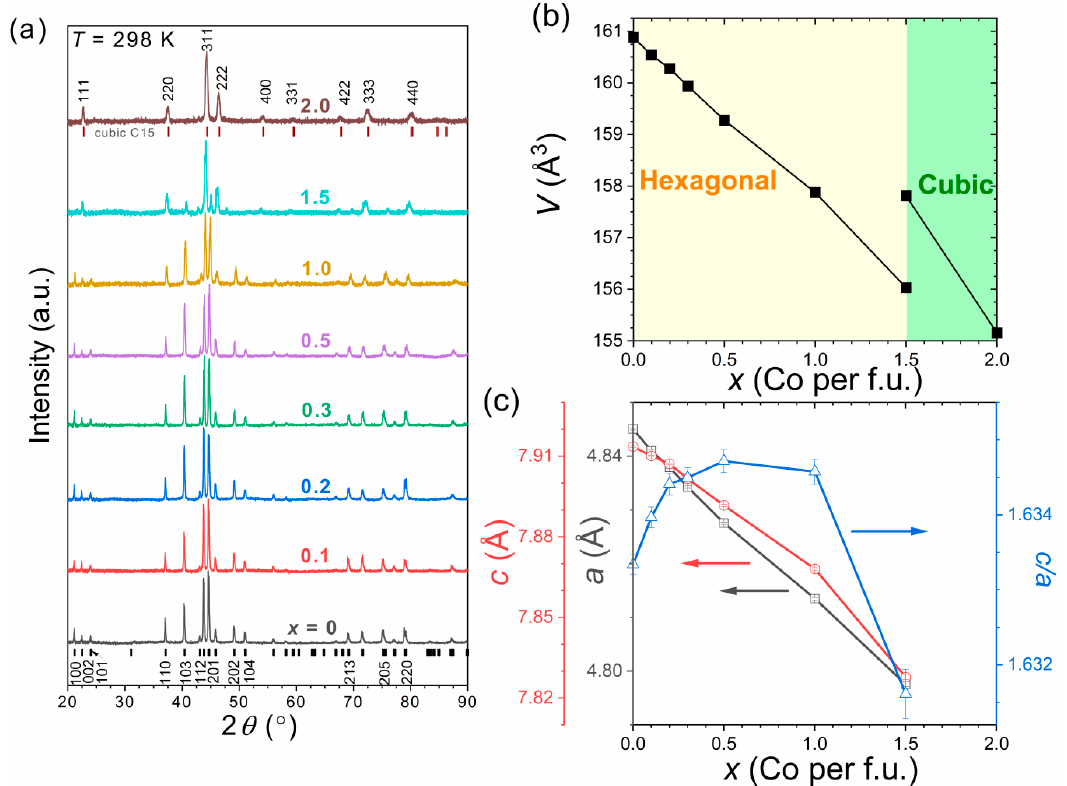
Figure 3. Crystal structure of Sc 0.28 Ti 0.72 Fe 2 − x Co x alloys at room temperature as a function of Co content ( x ): ( a ) powder diffraction patterns measured at room temperature—the ticks for the bottom and upper patterns mark out the reflections for hexagonal C14 and cubic C15 structures, respectively; ( b ) cell volume (half-cell volume for the cubic phase); ( c ) lattice parameters of the hexagonal phase.